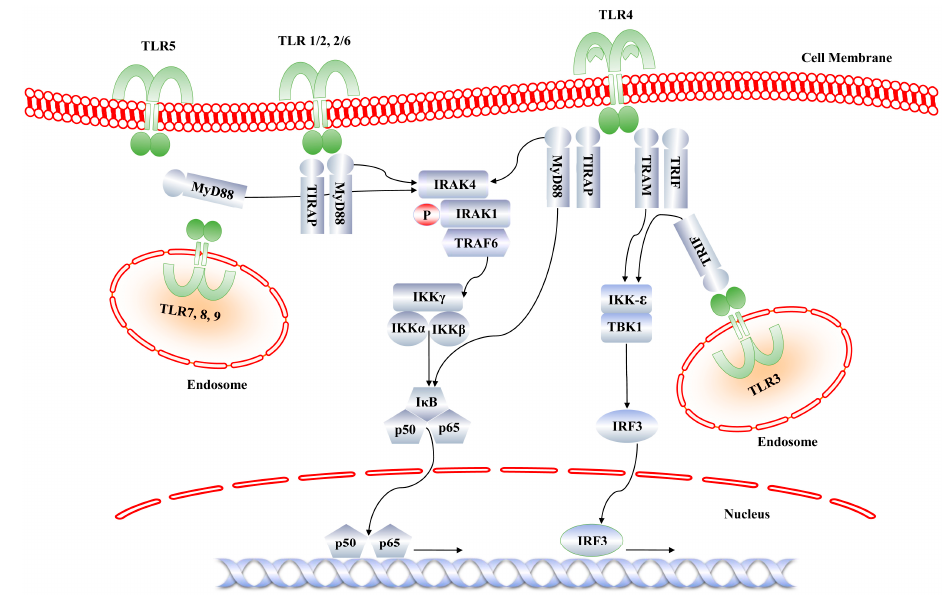
Figure 2. Toll-like receptor (TLR) signaling pathways. IRAK4) is the central kinase that mediates signal transduction from all TLRs, except TLR3 and TIR-domain-containing adapter-inducing interferon- β (TRIF)-dependent TLR4. MyD88 recruits IRAK4, which autophosphorylates and then phosphorylates IRAK1. The phosphorylated IRAK1 recruits TRAF6 and propagates signal transduction, resulting